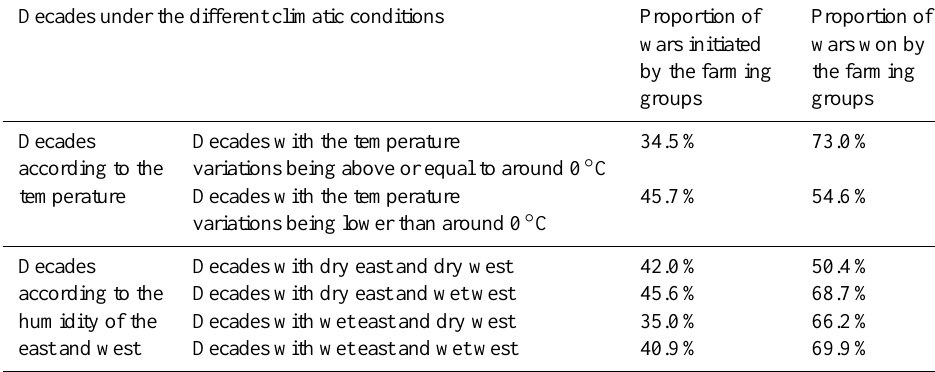
Table 4. Ethnic wars with climate change on a decadal